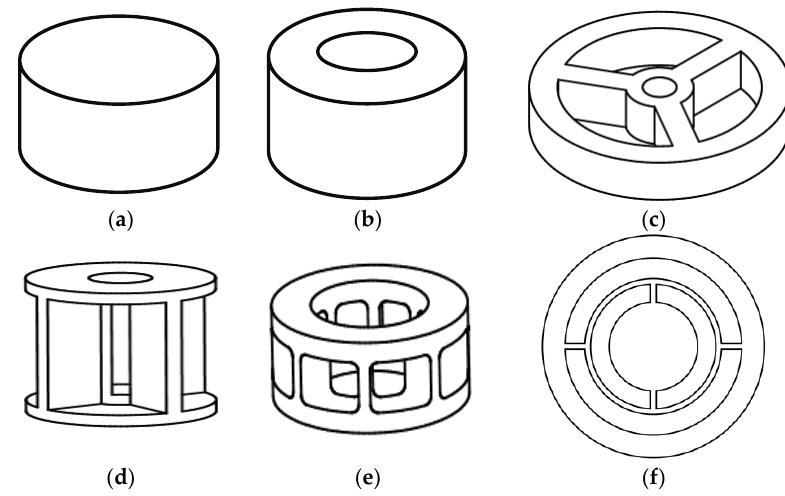
Figure 3. Various structures of torque sensor. ( a ) solid cylinder; ( b ) hollow cylinder; ( c ) hub sprocket; ( d ) hollow cruciform; ( e ) hollow hexaform; ( f ) spoke topology.